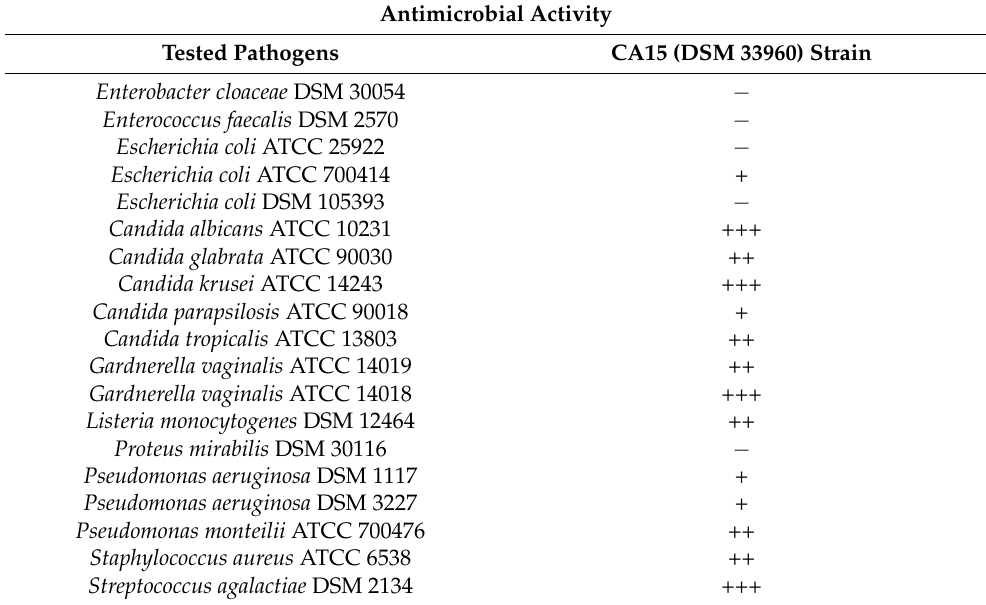
Table 2. Antimicrobial activity against pathogens exhibited by the L. rhamnosus CA15 (DSM 33960)